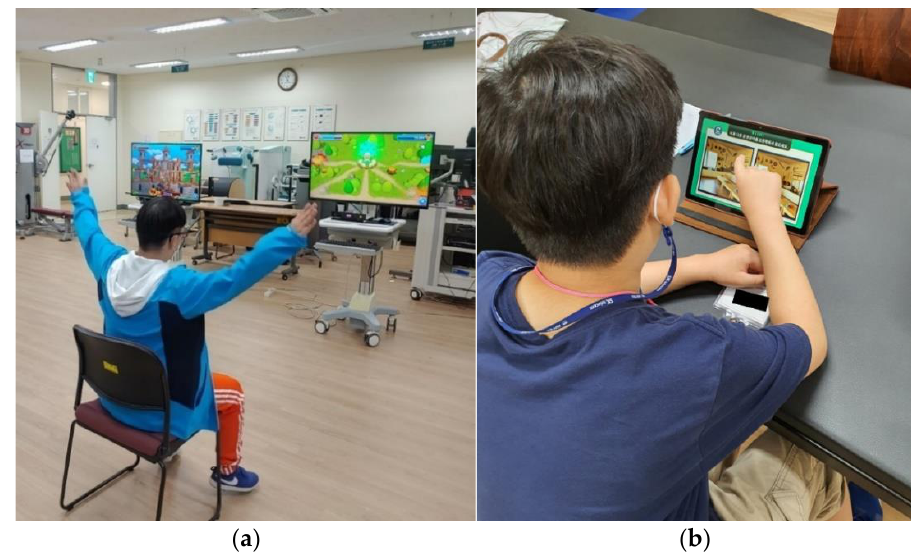
Figure 2. ( a ) AR game-based cognitive – motor training session, ( b ) CoTras-based training